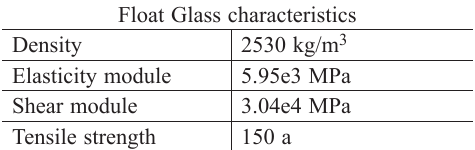
Table 2. Float Glass characteristics